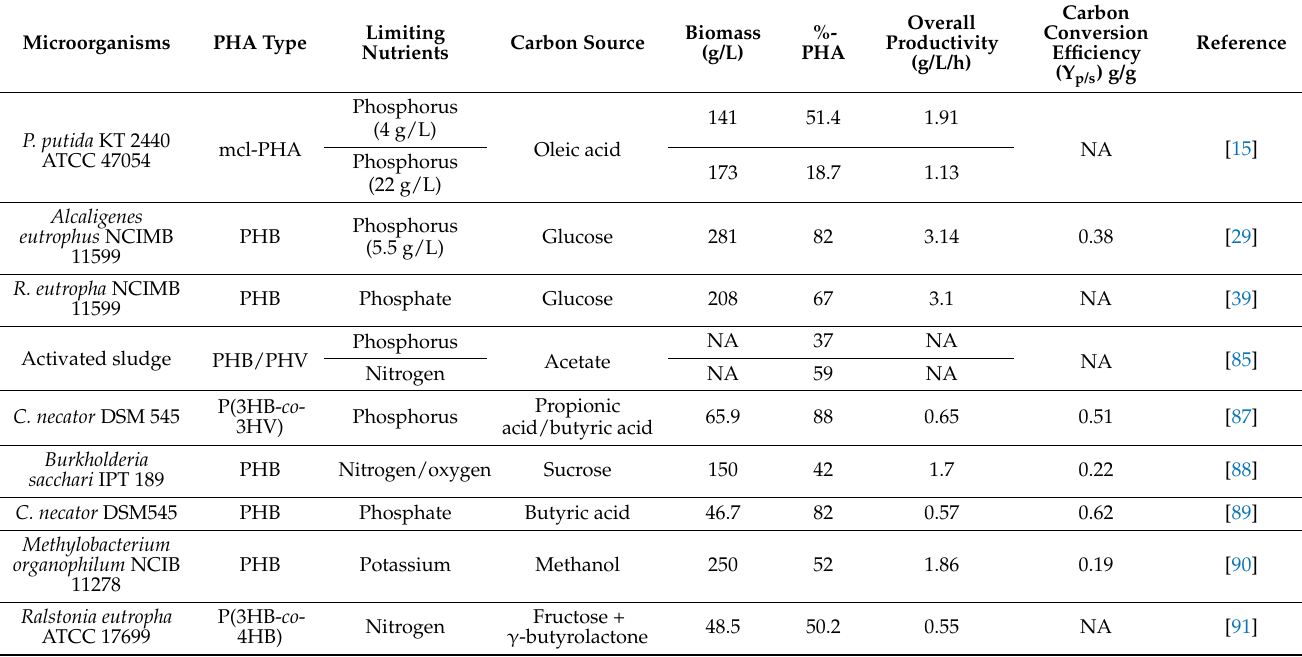
Table 3. Accumulation of PHA produced by different strains under nitrogen/phosphorus/oxygen limitation conditions.